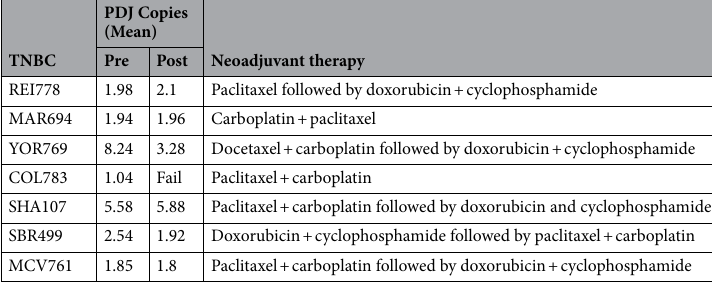
Table 5. Pre and post neoadjuvant TNBC.